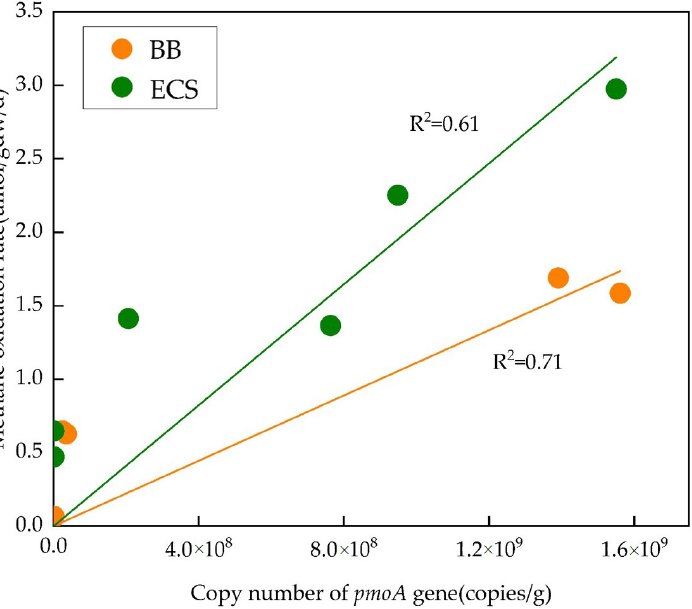
Figure 5. Correlation between CH 4 oxidation rates and average copy numbers of pmoA genes at different temperatures.